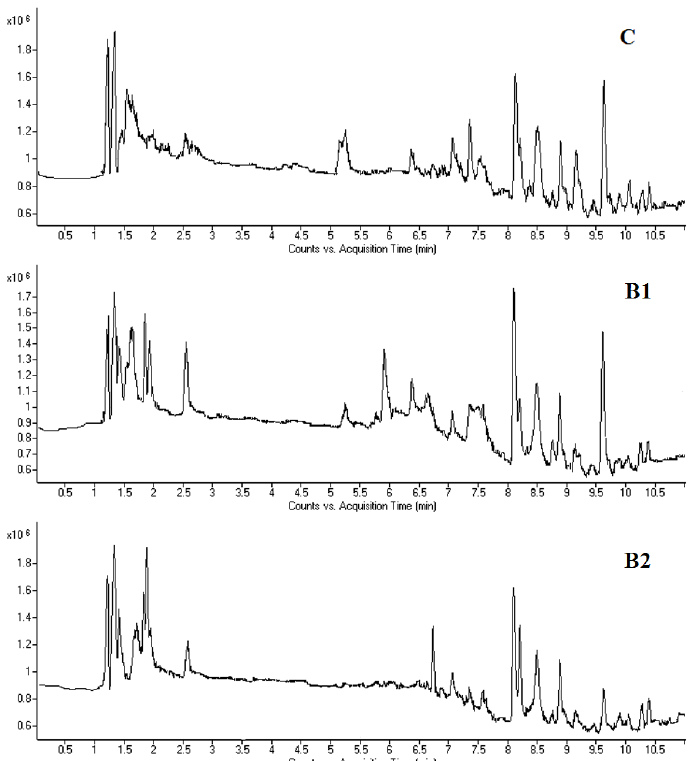
Figure 3. Total ion chromatograms (TICS) of bone marrow cell samples obtained from the control group ( C ), and benzene 1 ( B1 ) and benzene 2 groups ( B2 ) of male C3H/He mice following 7 days of benzene exposure, using LC/MS (positive